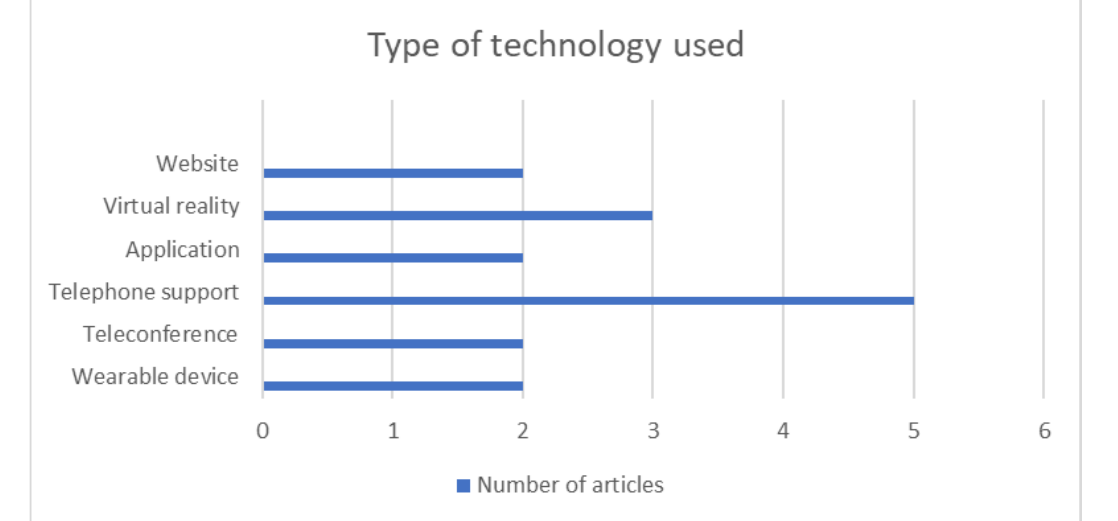
Figure 2. Type of technology used in selected articles.